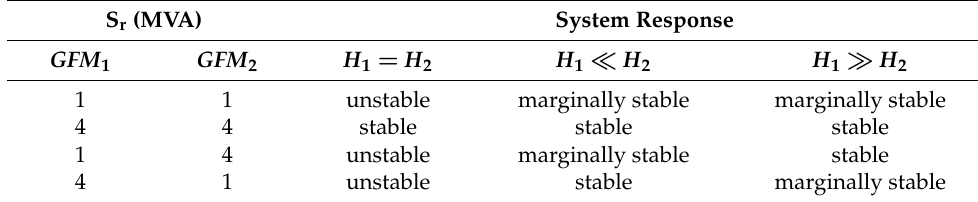
Figure 11. Impact of inertial effect in grid-forming converters. Table 2. Impact of rated powers and inertial